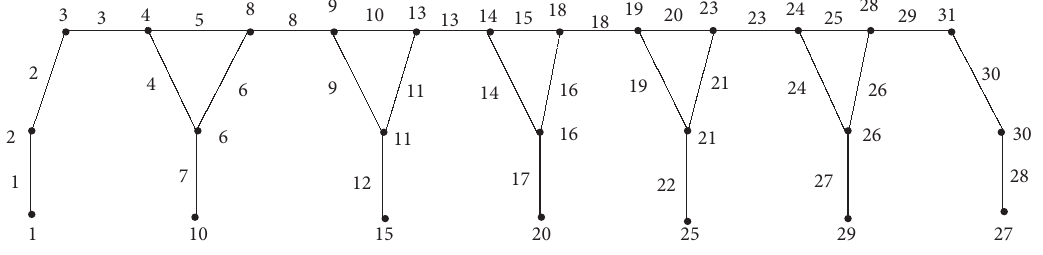
Figure 9: A classical mean labeling of L ( S ( P